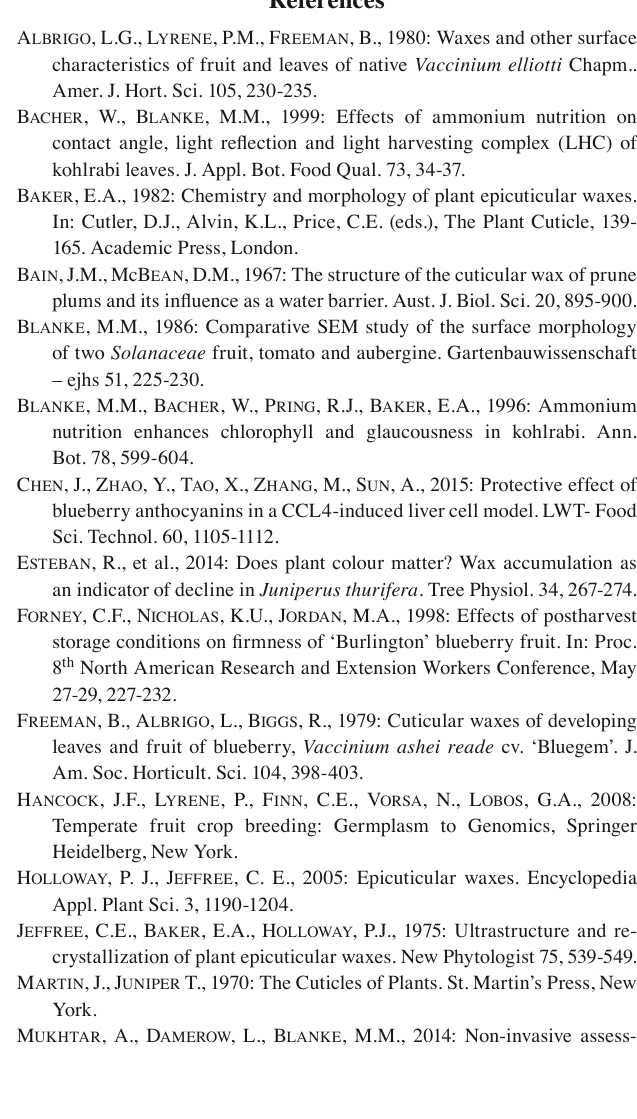
The positive correlation between the luster levels (Fig. 3) and polishing is in line with the work of m ukhtar et al. (2014), who reported that the luster levels of the natural wax surface of plum fruit remained almost constant at 100-200 a.u. or with little decrease over time, but increased 2-3 fold after